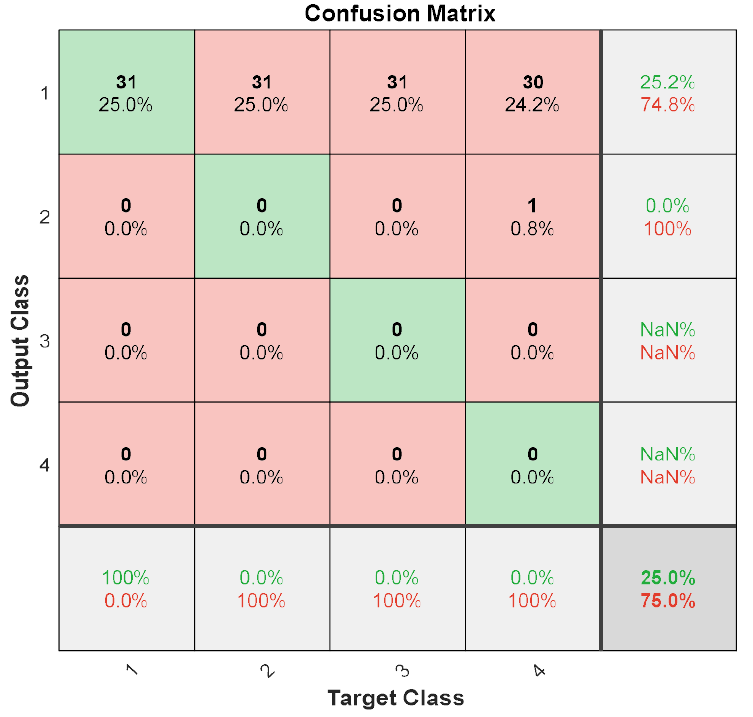
Figure 8. ROC of FE for noisy LFM by DNN.